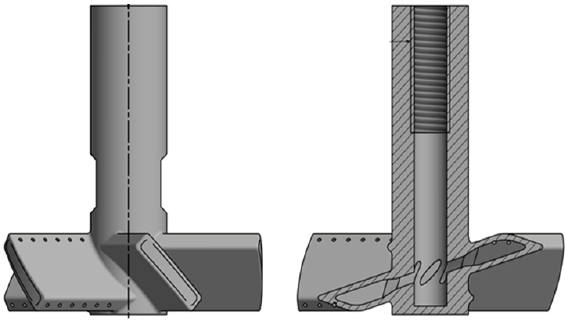
Figure 2. 3D model of the impeller used in this research. Image Processing The images of bubbles were captured for each test using different impeller speeds and aeration rates (Table 1), and the average count of image for each test was 100. Later, the images were further preprocessed using a custom script developed using standard Python libraries [17]. First, the color (RGB) images were converted to grayscale and Gaussian smoothed to reduce noise [18]. Then, a Canny edge detector found the bubble outlines/edges, which were processed by a circular Hough transform to find the circle candidates. Finally, non-maxima-suppression (NMS) was used to remove low confidence duplicate detections [19]. Table 1. Test conditions and calculated hydrodynamics, where M1-M10 depict the measurement parameters. Aeration